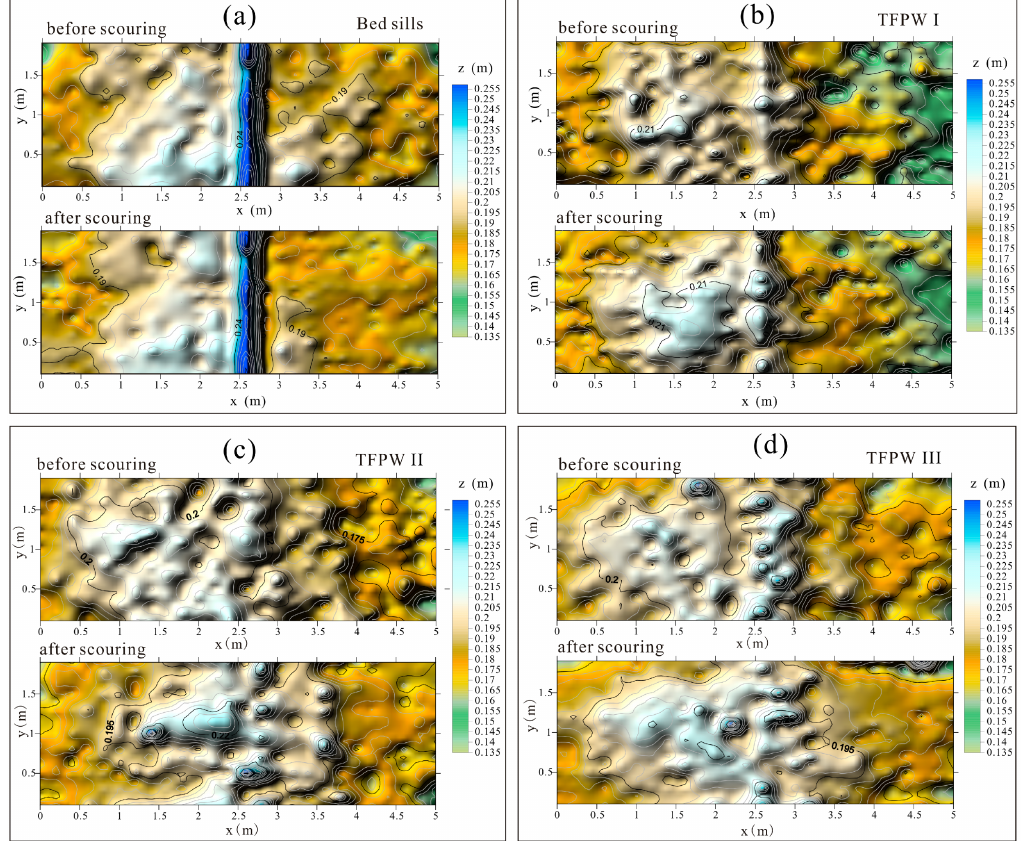
Figure 8. Topography variations of riverbed before and after scouring under different structural conditions: ( a ) without bed sills; and ( b – d ) under the protection of TFPW I–III,